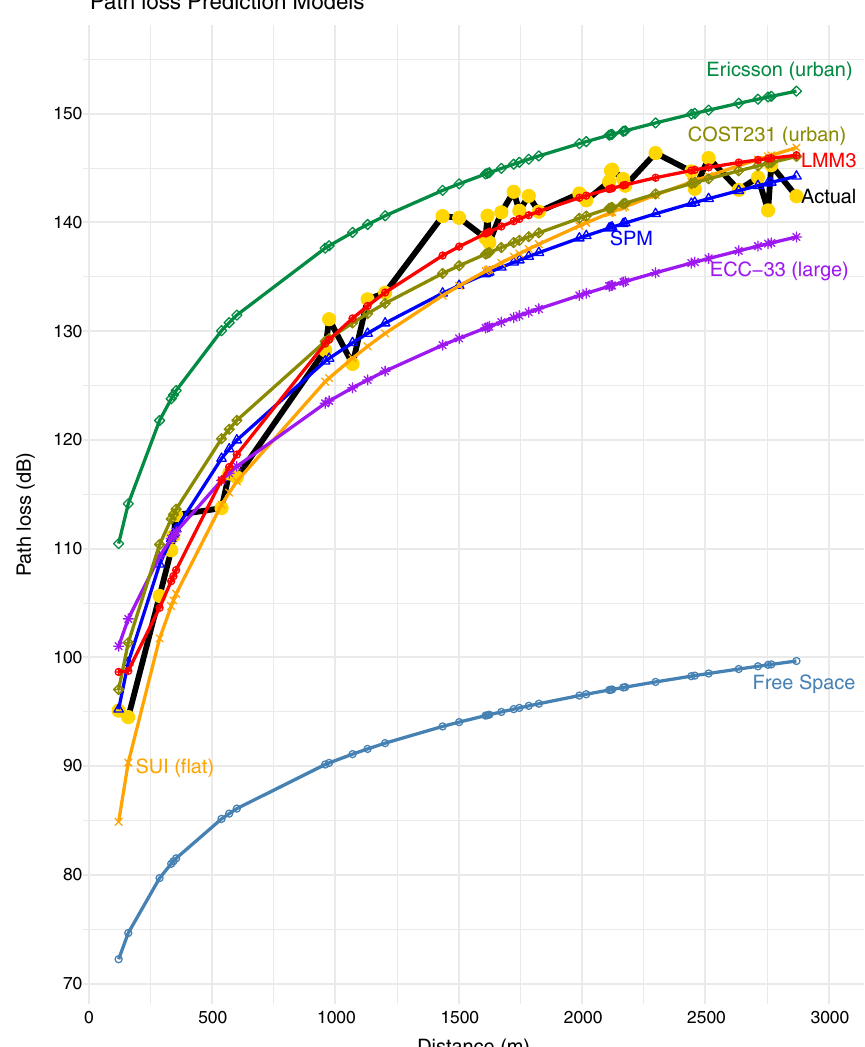
Fig. 6 Actual path loss measurements with their predictions using different